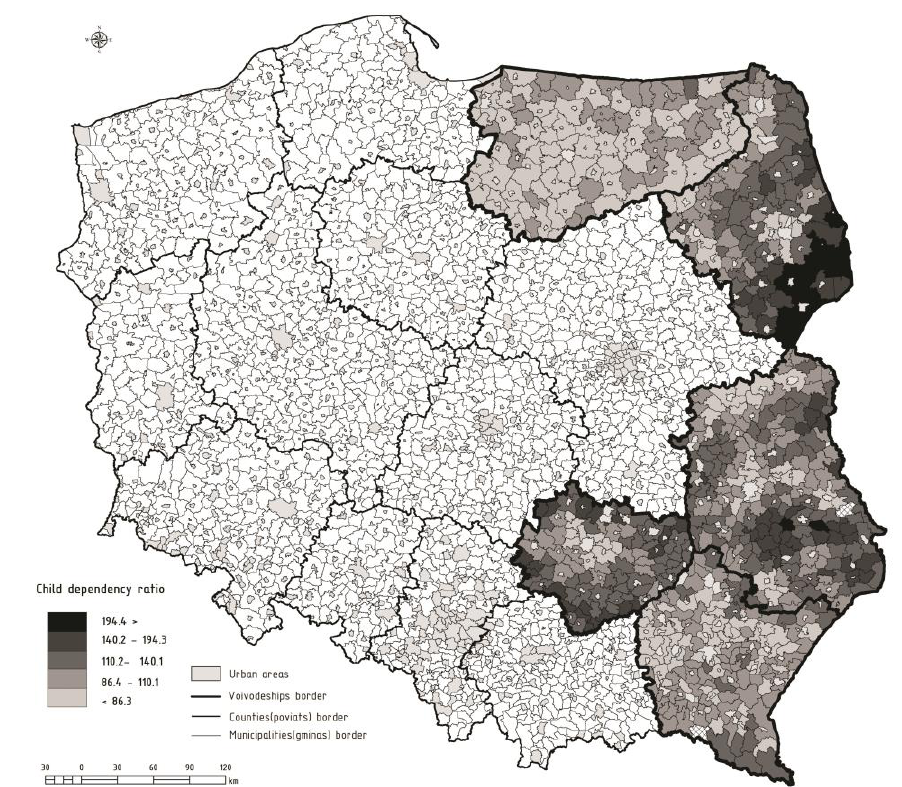
Fig. 10. Post-working age population per 100 persons of pre-working age in rural areas of Eastern Poland in 2020